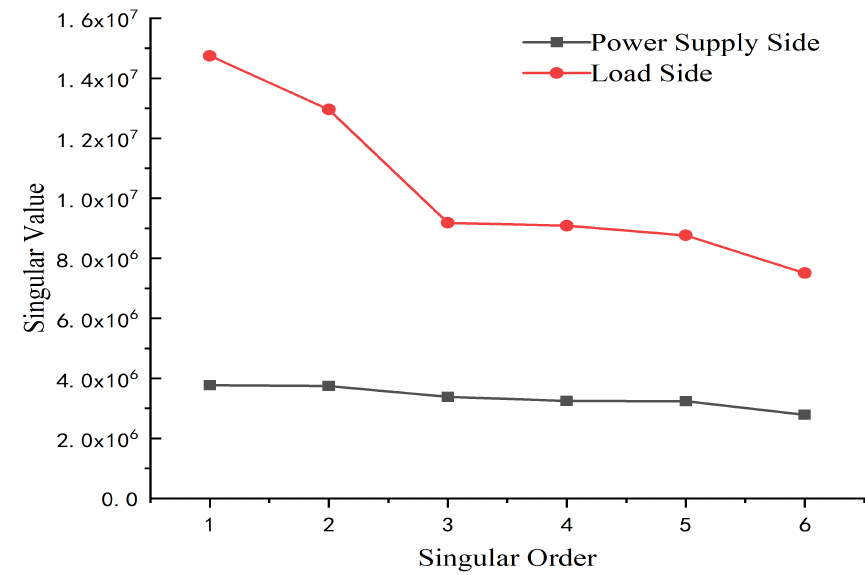
Figure 8. Results of SVD of characteristic matrix for VFTO at power side and load side. The wavelet energy values of each order E i of the VFTO from the power side and the load side were obtained by simulation, as shown in Figure 9.